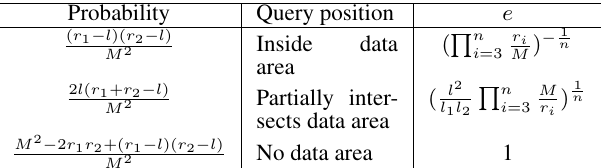
Table 3. Effectiveness of HistTree for 2- n D query, l ≤ min